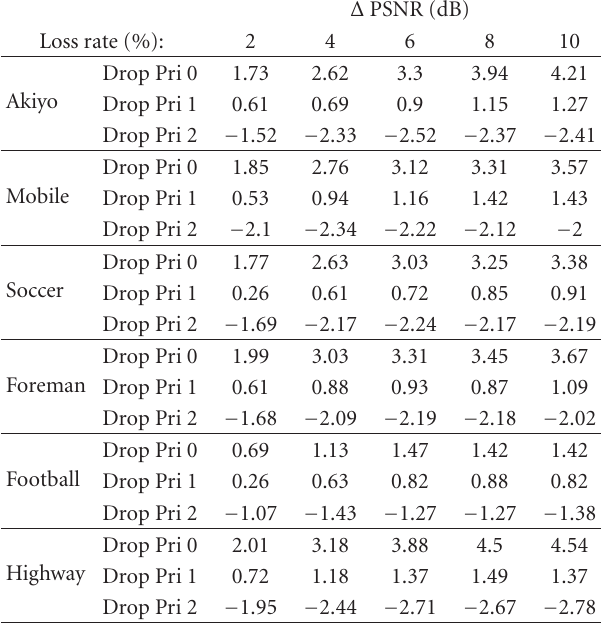
Table 1: Mean Y-PSNR gain (loss) when dropping di ff erent priority packets, as compared to dropping randomly over a range of test sequences.